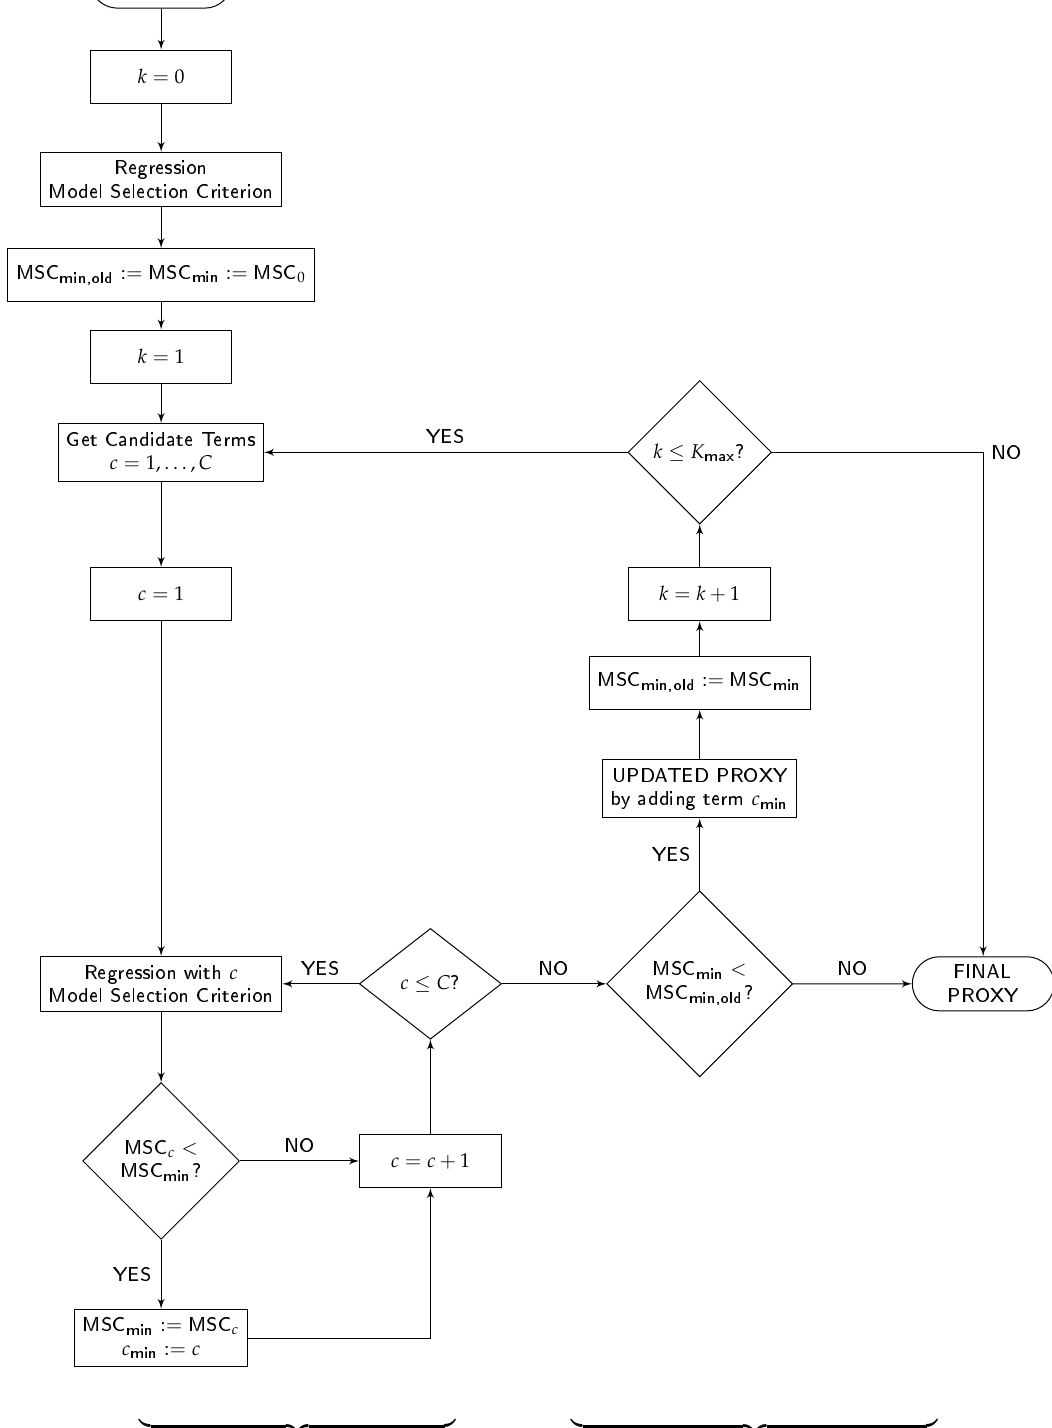
Figure 2. Flowchart of the calibration algorithm